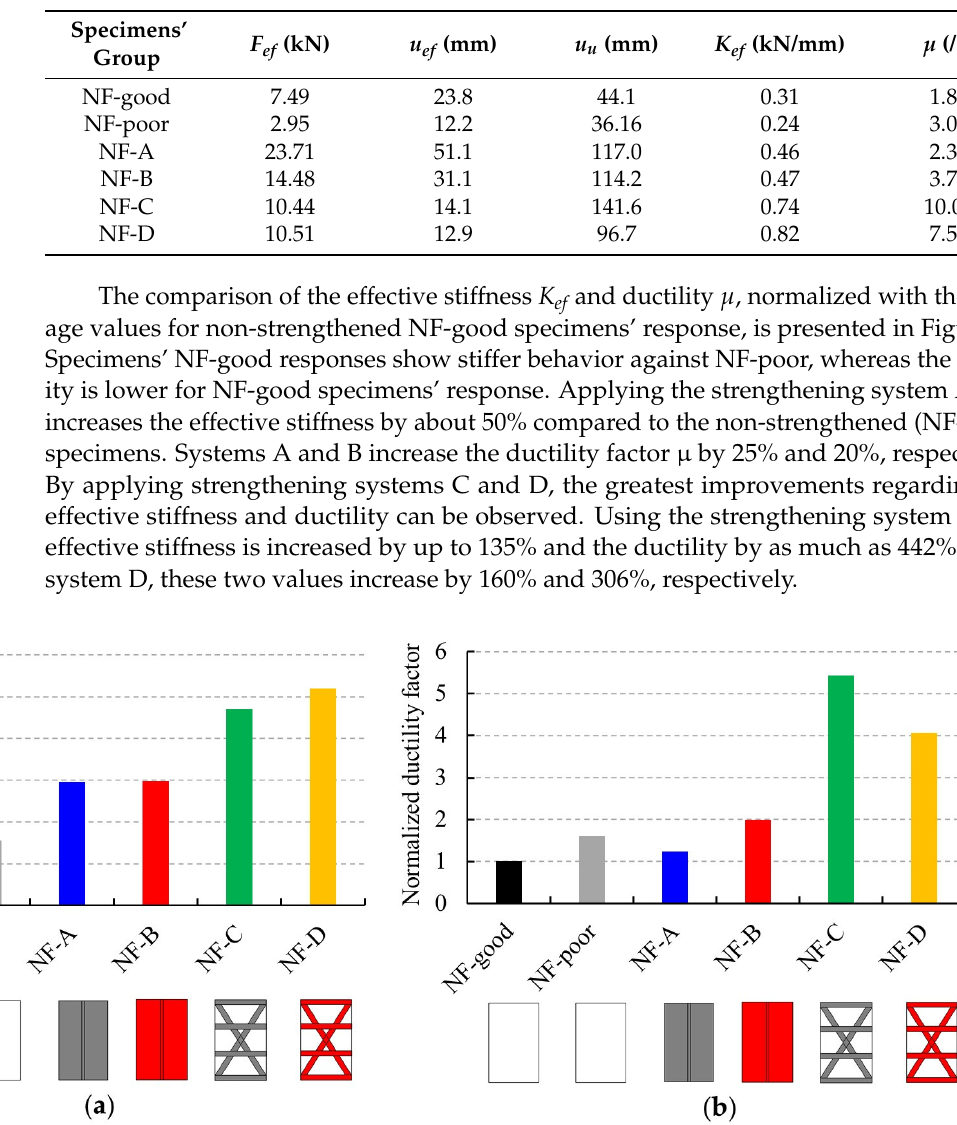
Table 3. Values of average idealized bilinear curves at the characteristic points ( F ef , u ef , u max ) and effective stiffness K ef and ductility µ .